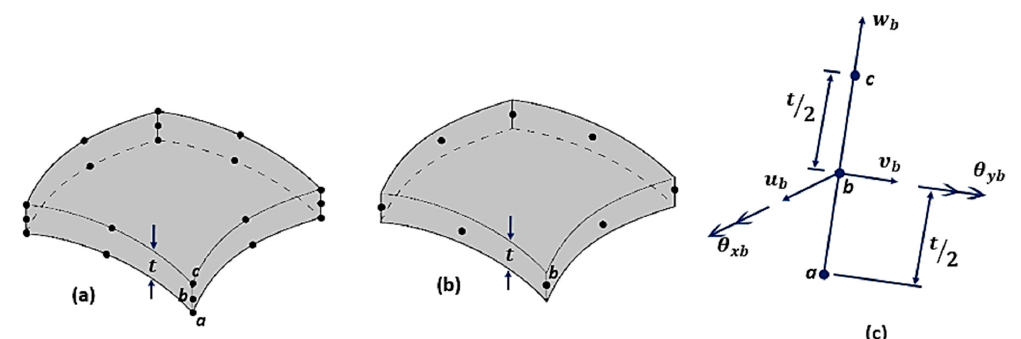
Figure 22. ( a ) 20-node isoparametric solid element; ( b ) reduction to eight nodes using a shell element; and ( c ) b-node representation .